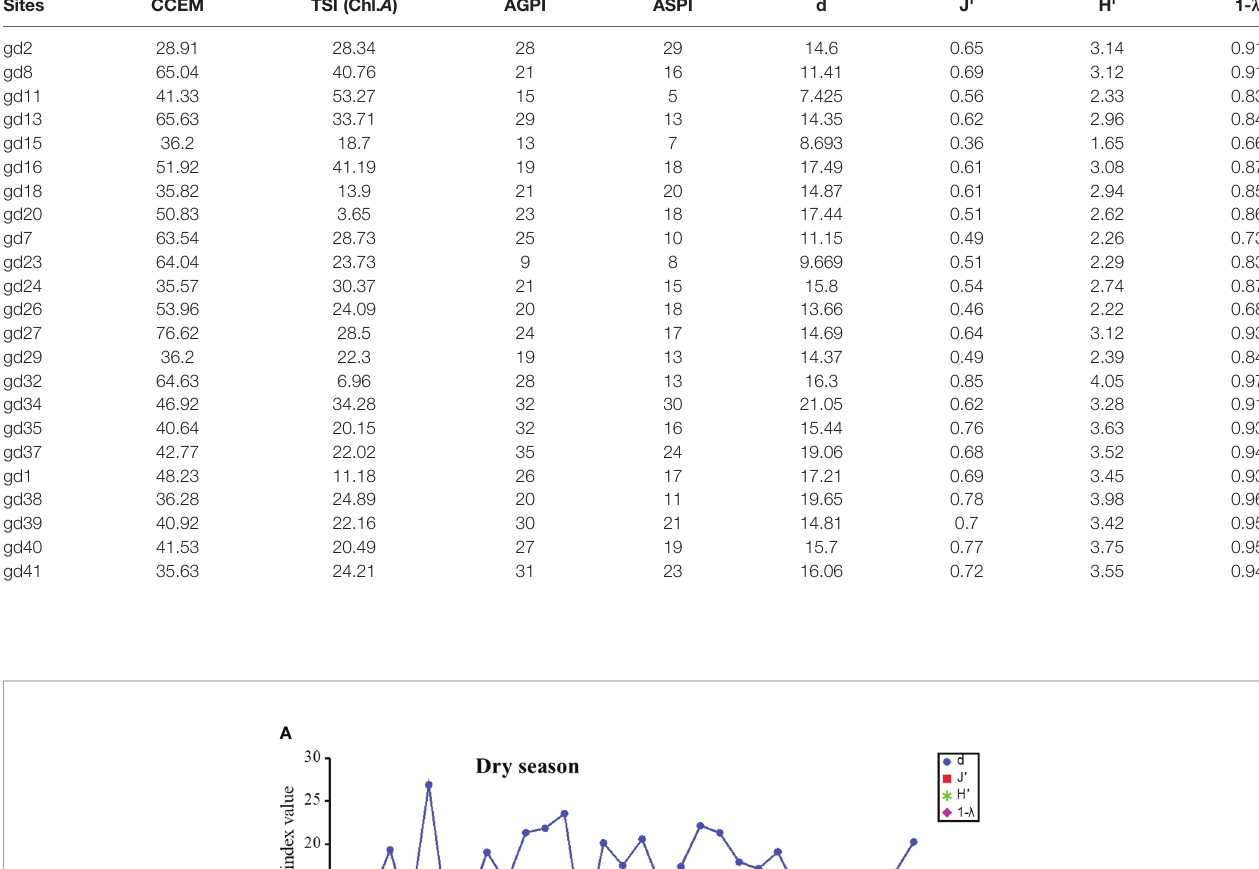
TABLE 6 | The calculated indices values during the wet season across the mangroves. Sites